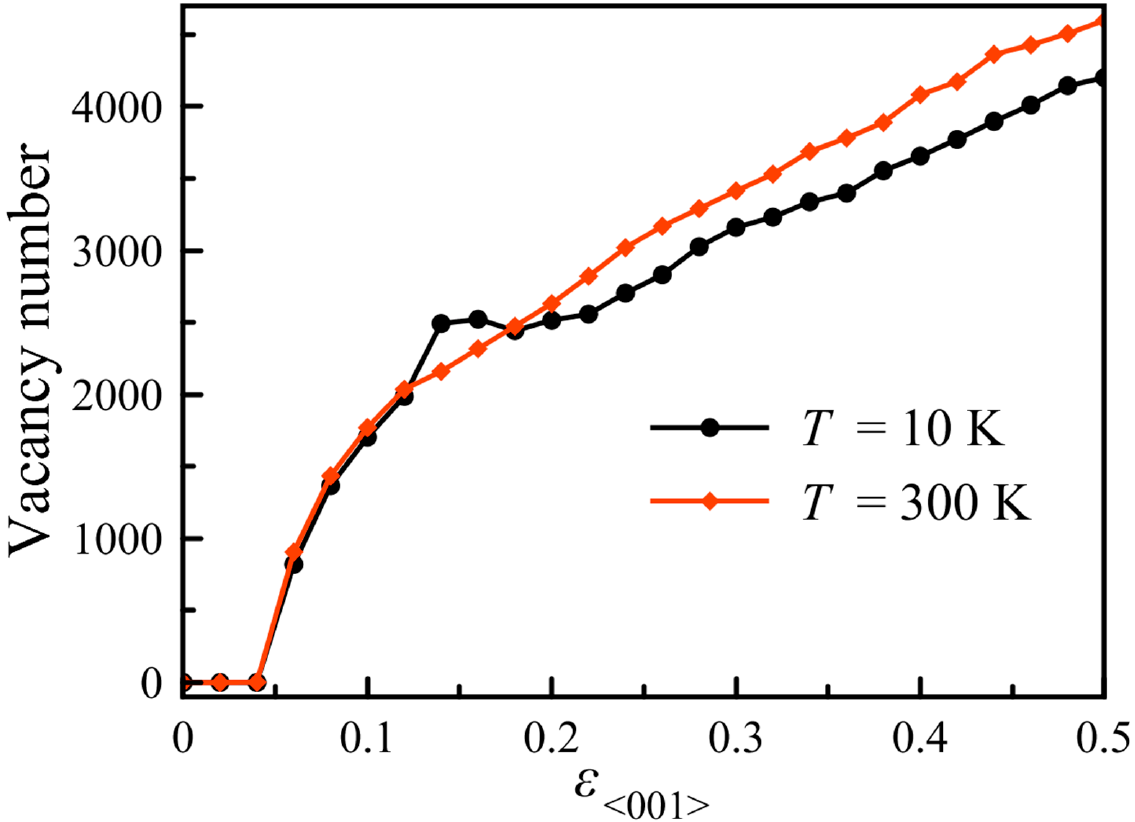
Figure 6. Vacancy number for uniaxial tensile loading of TiAl alloy in the <001> direction. The black and red circles represent the loading process at 10 and 300 K, respectively.